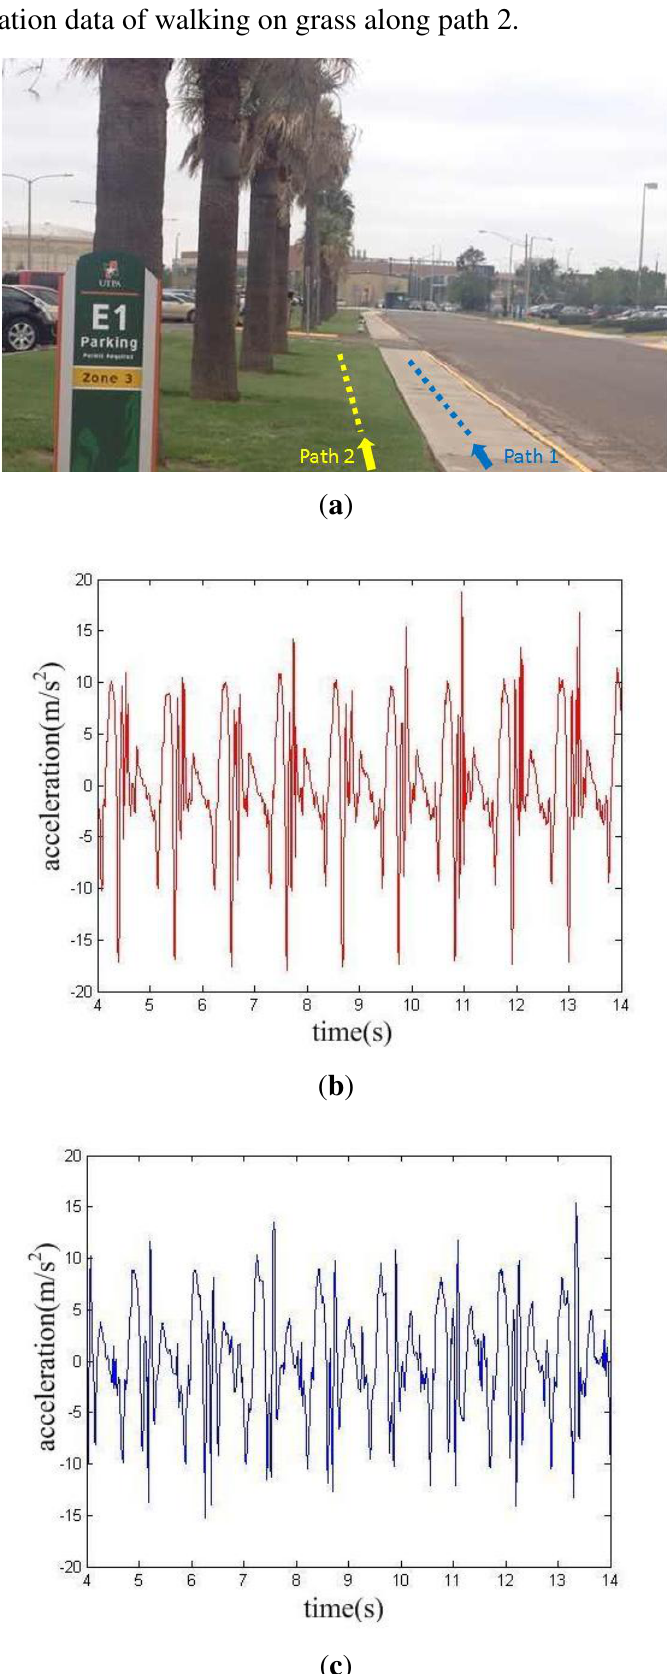
Figure 6. Comparison experiment with different ground conditions. ( a ) Test conditions and the two test paths. ( b ) Linear acceleration data of walking on cement pavement along path 1. ( c ) Linear acceleration data of walking on grass along path